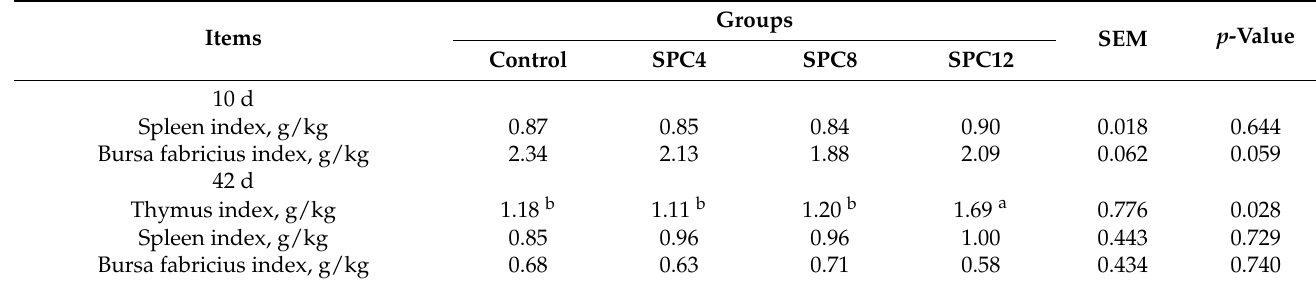
Table 7. Effects of dietary SPC in starter diet on immune organ index of broilers.